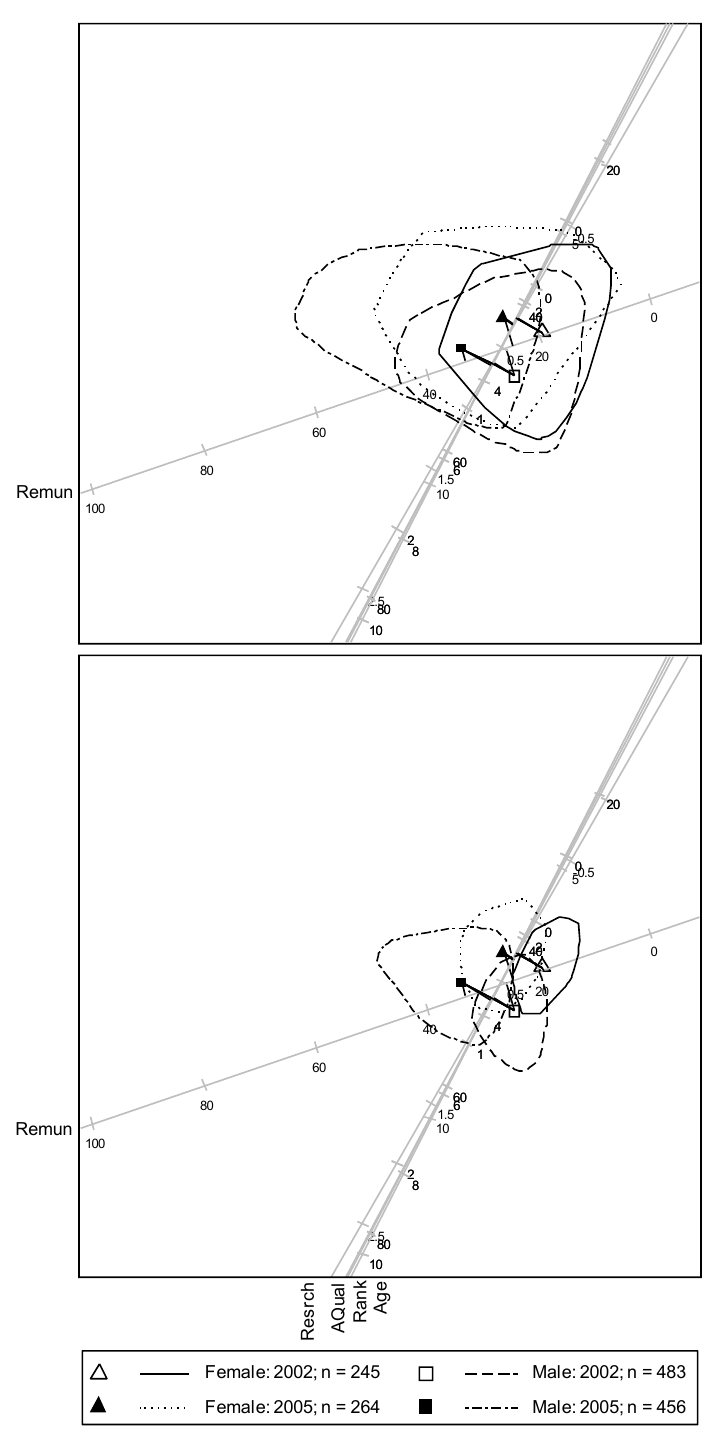
Figure 1: CVA biplot separating the data set of all C1 staff according to the 2002 Female, 2005 Female, 2002 Male and 2005 Male subgroups. Plotting of data points is suppressed. The upper panel shows the biplot overlaid with 90% bags; the lower panel with 50%